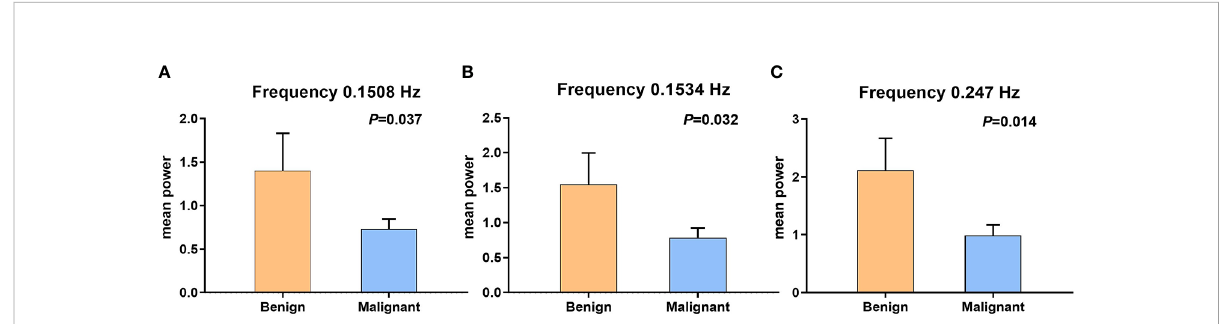
FIGURE 2 The error bars of two sample t -test between benign and malignant tumors, which have statistical signi fi cance. (A) Fifty-eighth frequency point (0.1508 Hz); P -value is 0.037. (B) Fifty-ninth frequency point (0.1534 Hz); P -value is 0.032. (C) Ninety- fi fth frequency point (0.247 Hz); P -value is